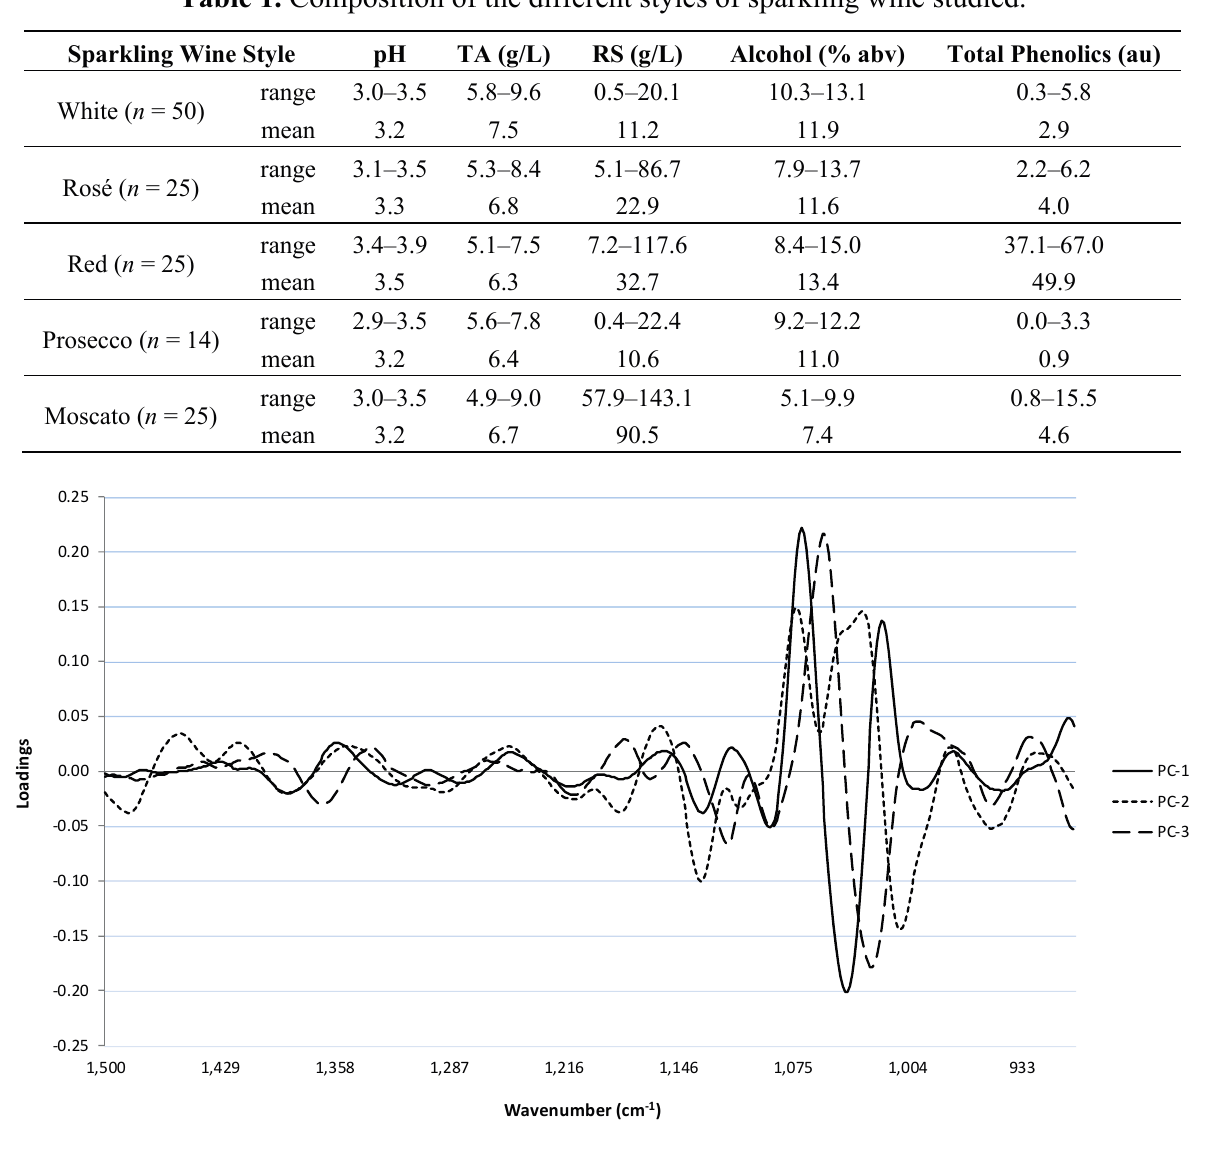
Figure 3. Loadings for the first three principal components for the fingerprint region derived from the MIR spectra of the sparkling